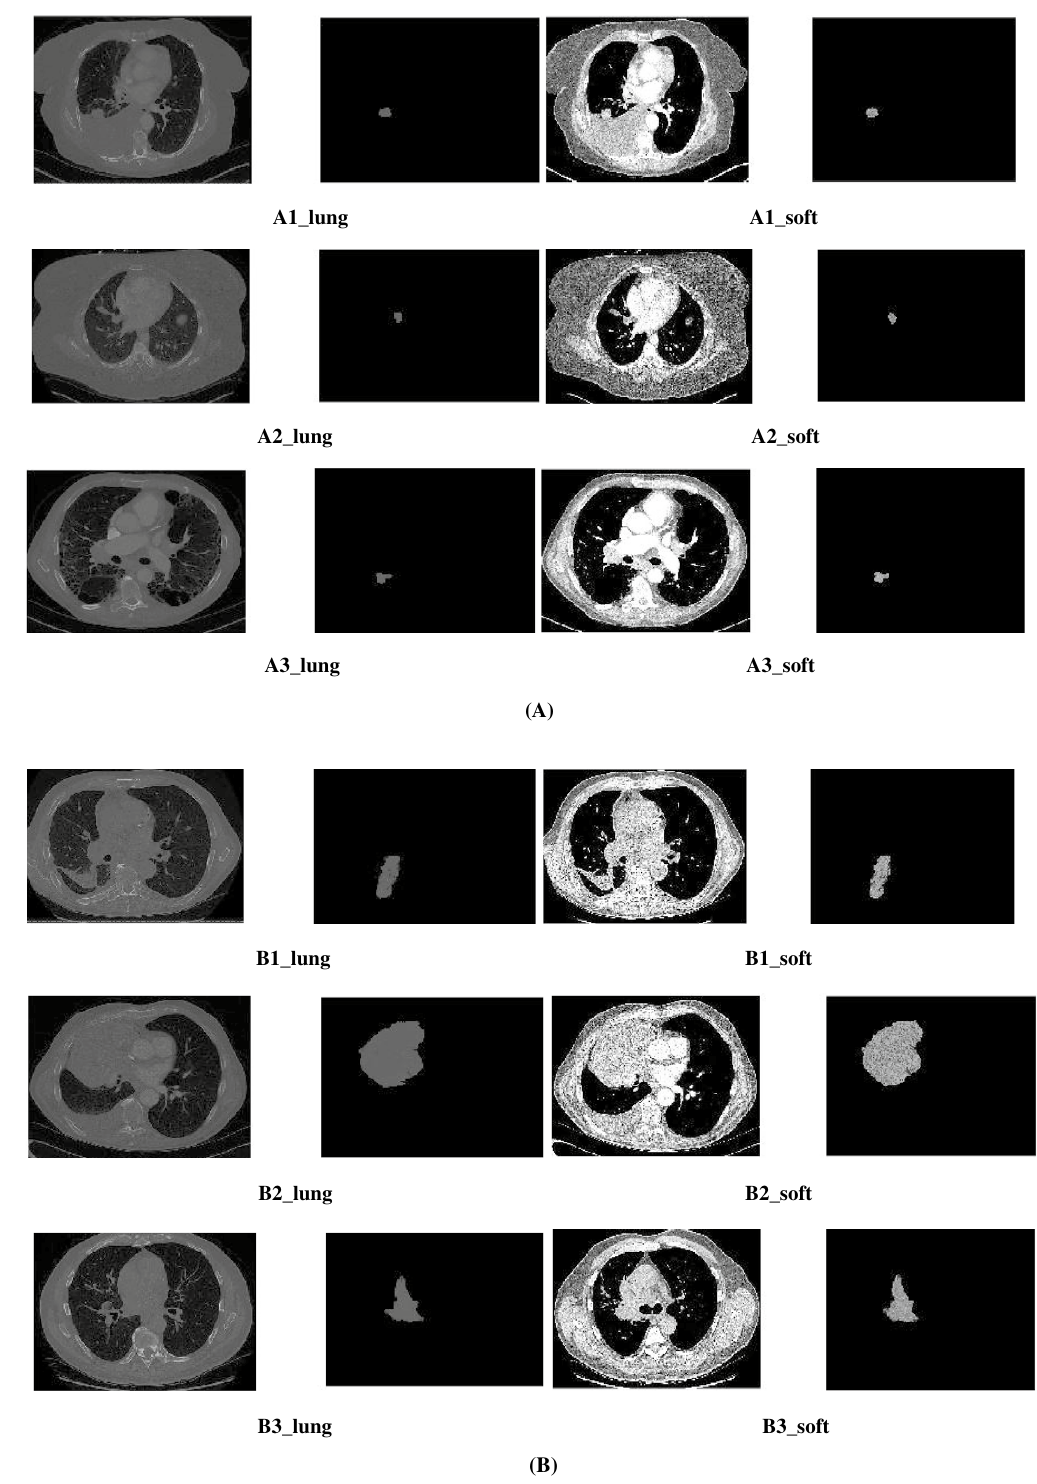
Figure 7. ( A ) Representative tumors belonging to phenotype 1- A_lung and A_soft represent the lung and soft tissue windows respectively. ( B ) Representative tumors belonging to phenotype 2- B_lung and B_soft represent the lung and soft tissue windows